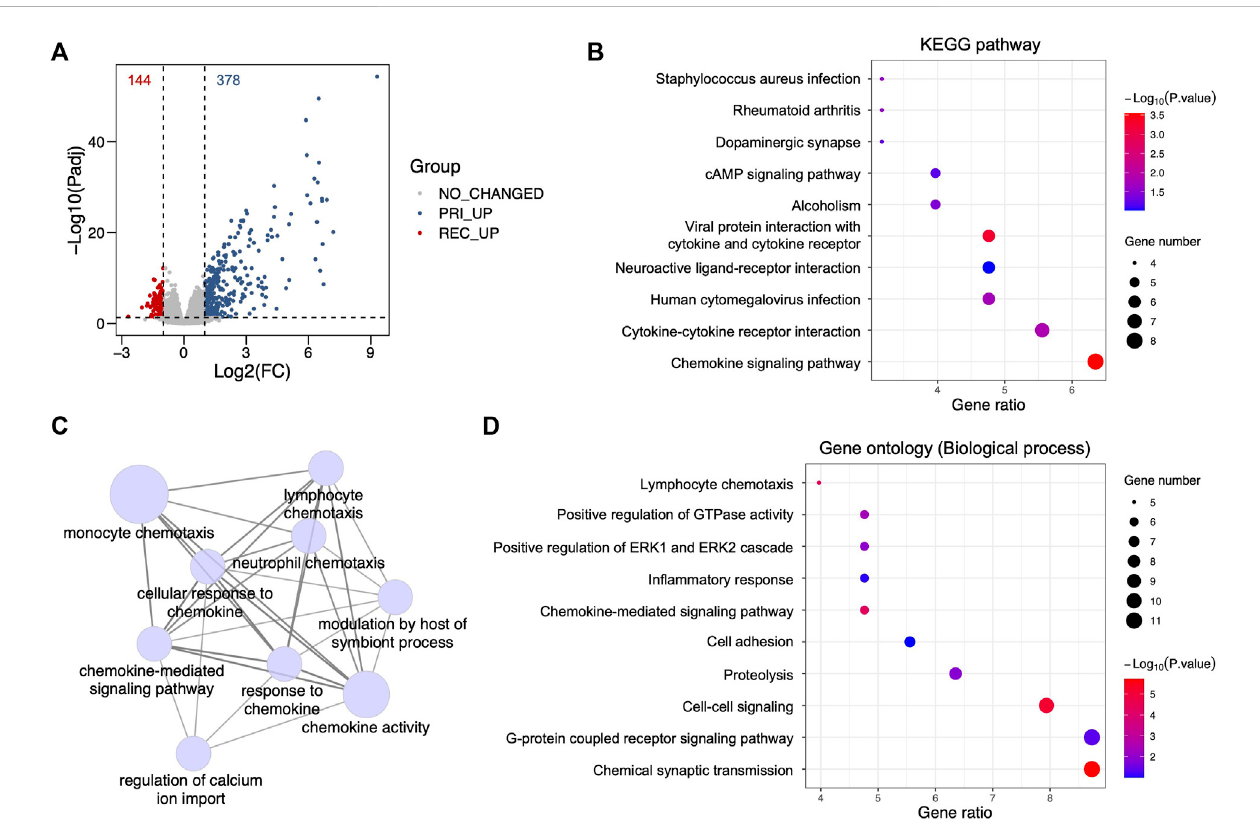
FIGURE 1 Identi fi cationofdifferentiallyenrichedsignalingpathwaysfromrecurrentglioblastoma. (A) Volcanoplotshowingdifferentiallyexpressedgenesbetween primaryandrecurrentglioblastoma(GBM)fromtheChineseGliomaGenomeAtlas(CGGA)cohortusingacriterionwithfoldchange(FC)andadjacent p -value (Padj). Red dots, upregulated genes in recurrent GBM, Log 2 (FC) < -1 and Padj < 0.05; gray dots, genes showing no changed FC and no signi fi cant p -value, | Log 2 (FC)| < 1 and Padj > 0.05; blue dots, upregulated genes in primary GBM, Log 2 (FC) > 1 and Padj < 0.05. (B) Bubble plot for the Kyoto Encyclopedia of Genes and Genomes (KEGG) pathway analysis with upregulated genes in recurrent GBM from the CGGA cohort. (C) Signaling network showing the ClueGO analysis for the biological process of gene ontology (GO-BP) with upregulated genes in recurrent GBM from the CGGA cohort. (D) Bubble plot showing the GO-BP terms with upregulated genes in recurrent GBM from the CGGA